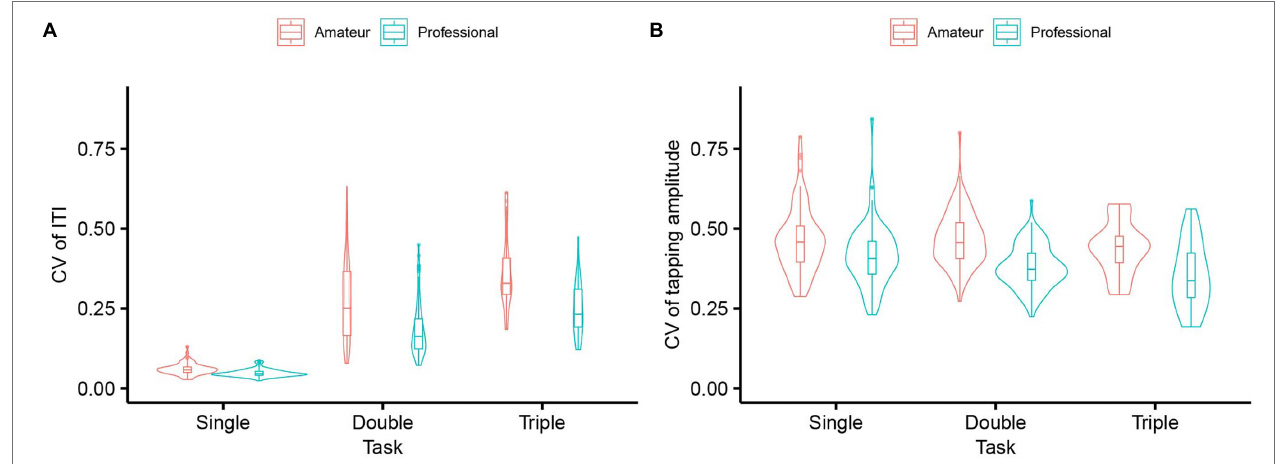
FIGURE 6 | (A) Coefficient of variation (CV) of inter-tap interval (ITI) of professional and amateur darbuka players in the single-, double- and triple-finger tapping tasks ( n = 8 for the professional group and n = 8 for the amateur group). (B) CV of tapping amplitude of professional and amateur darbuka players in the single-, double- and triple-finger tapping tasks ( n = 8 for the professional group and n = 8 for the amateur